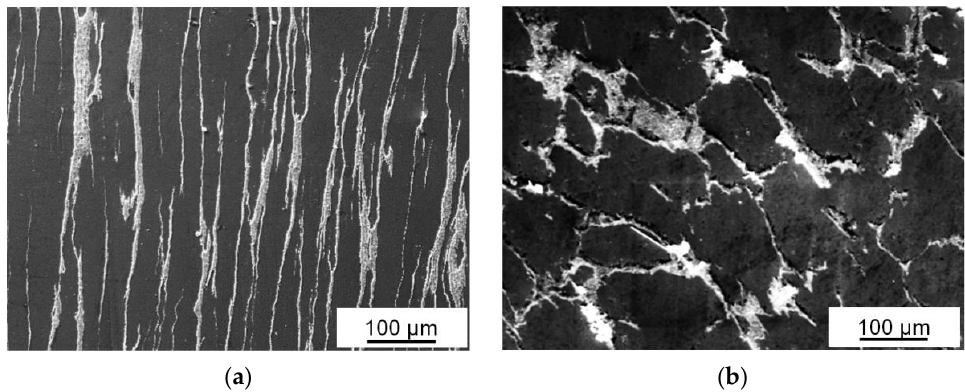
Figure 6. SEM (SE) images of the structure of Al-30Sn alloy in the flow plane of the sample after two passes by ECAP with routes A ( a ) and C ( b ).